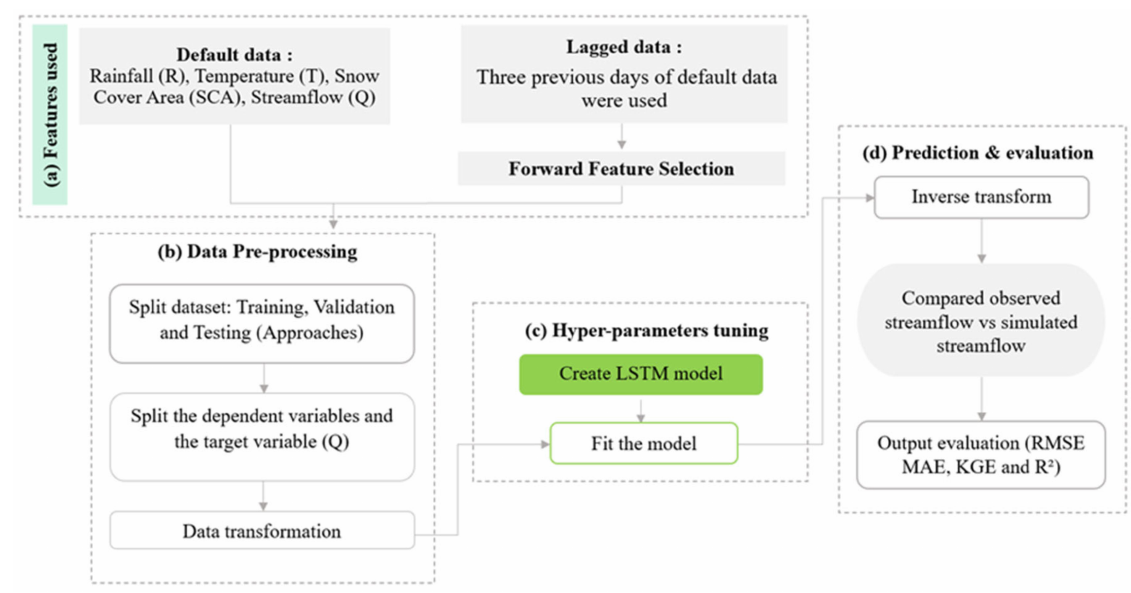
Figure 4. Flowchart of the modeling process for streamflow prediction model.